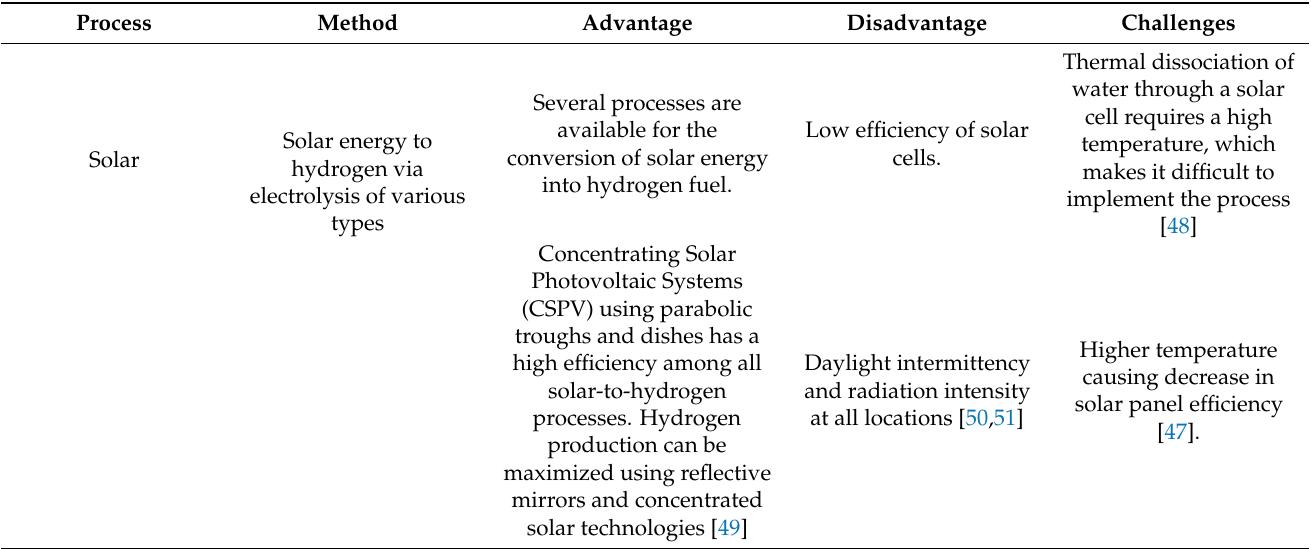
Table 7. Reviews the benefits, drawbacks, and challenges associated with hydrogen production processes from renewable